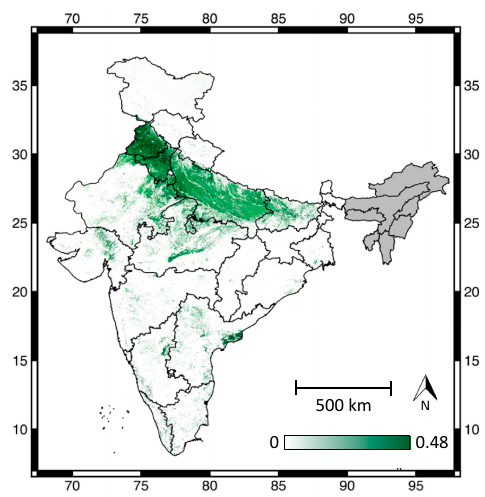
Figure 1. Study region is highlighted with the peak Enhanced Vegetation Index (EVI) from MODIS satellite data during the winter season growing season (1 October to 31 March) of 2001–2002. White represents pixels that did not exhibit a hump-shaped phenology and dark green represents high peak EVI values for pixels that exhibited a hump-shaped phenology after spline-smoothing the EVI time series. The northeastern states that were not considered in our study are highlighted in gray.